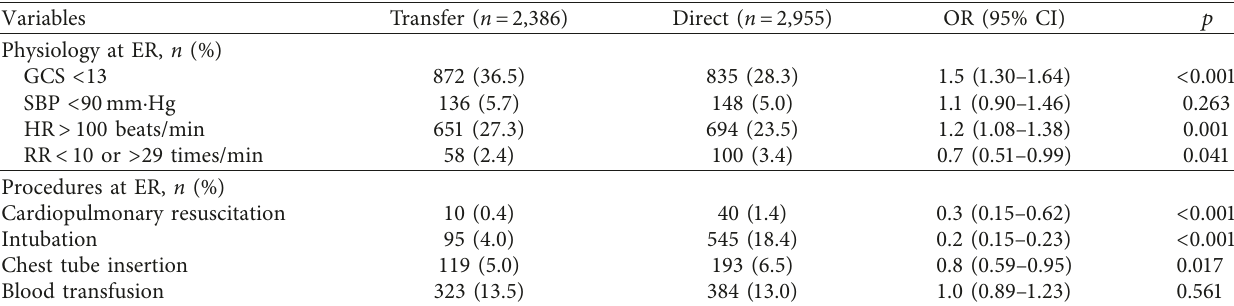
Table 3: Comparison of the outcome between the propensity score-matched cohorts of patients who were transferred and visited trauma centers directly.